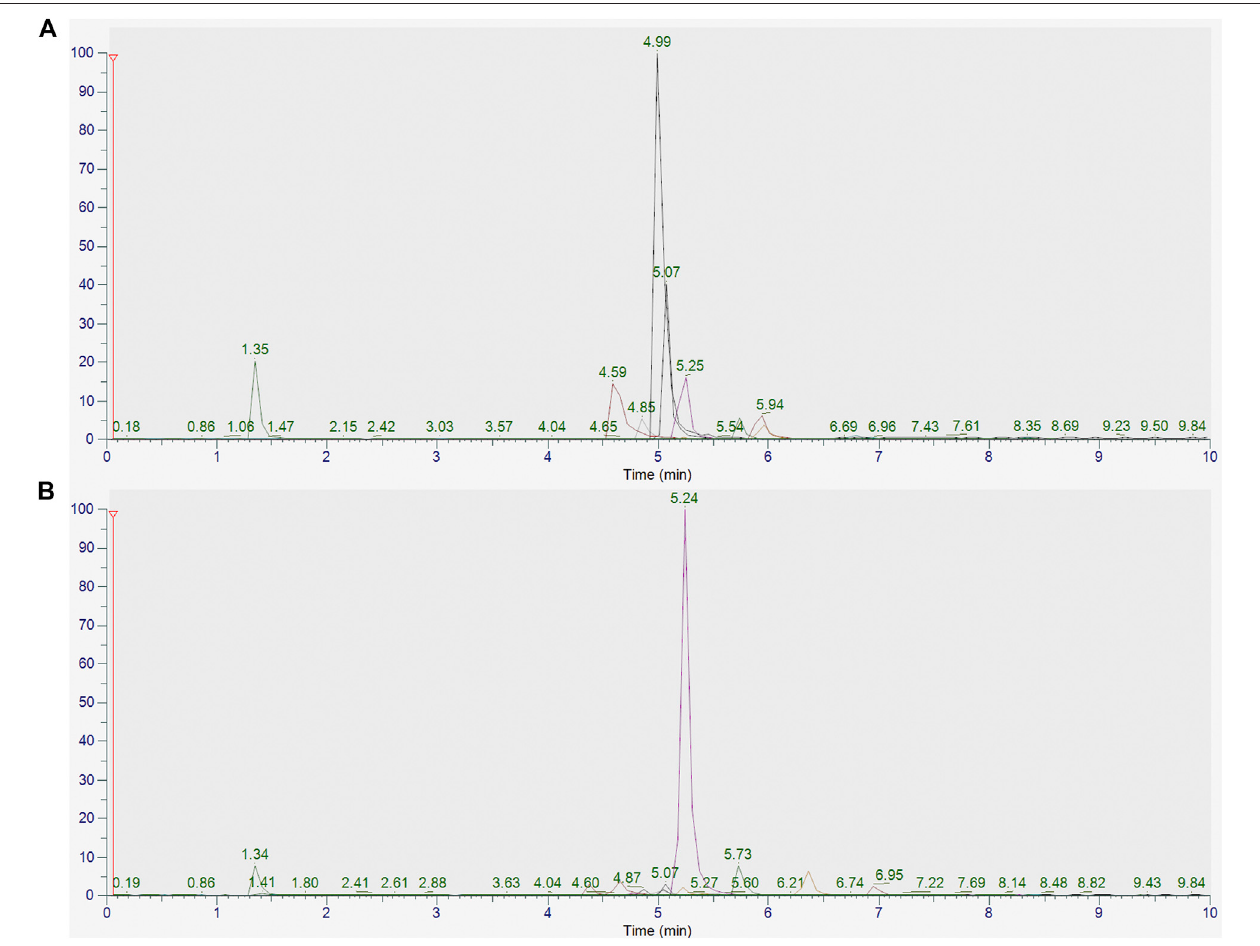
FIGURE 2 | (A) UPLC-Q-Orbitrap HRMS analysis of standards (betaine, chlorogenic acid, caffeic acid, berberine, hyperoside, notoginsenoside R1, hesperidin, ginsenoside Rb1, luteolin, quercetin, and ferulic acid). (B) UPLC-Q-Orbitrap HRMS analysis of MMXM.